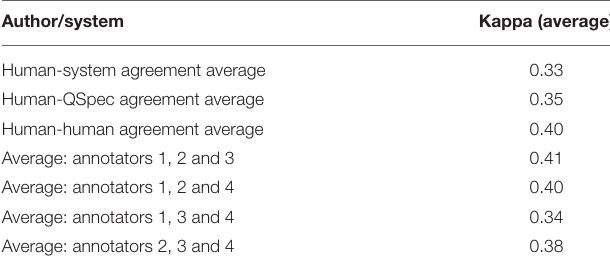
TABLE 3 | Average agreements between the system and human annotators, all human annotators and